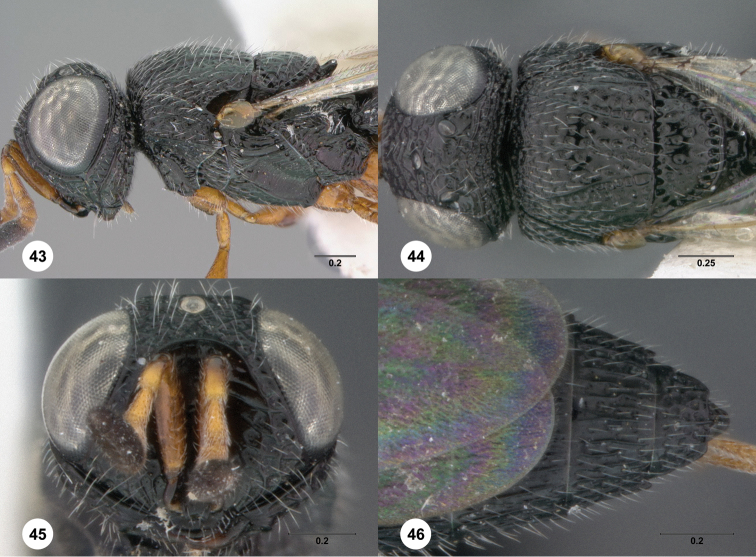
Oxyscelio clivi sp. n., holotype female (OSUC 359627) 43 Head and mesosoma, lateral view 44 Head and mesosoma, dorsal view. Paratype female (OSUC 462732) 45 Head, anterior view 46 Metasomal apex, dorsal view. Morphbank35